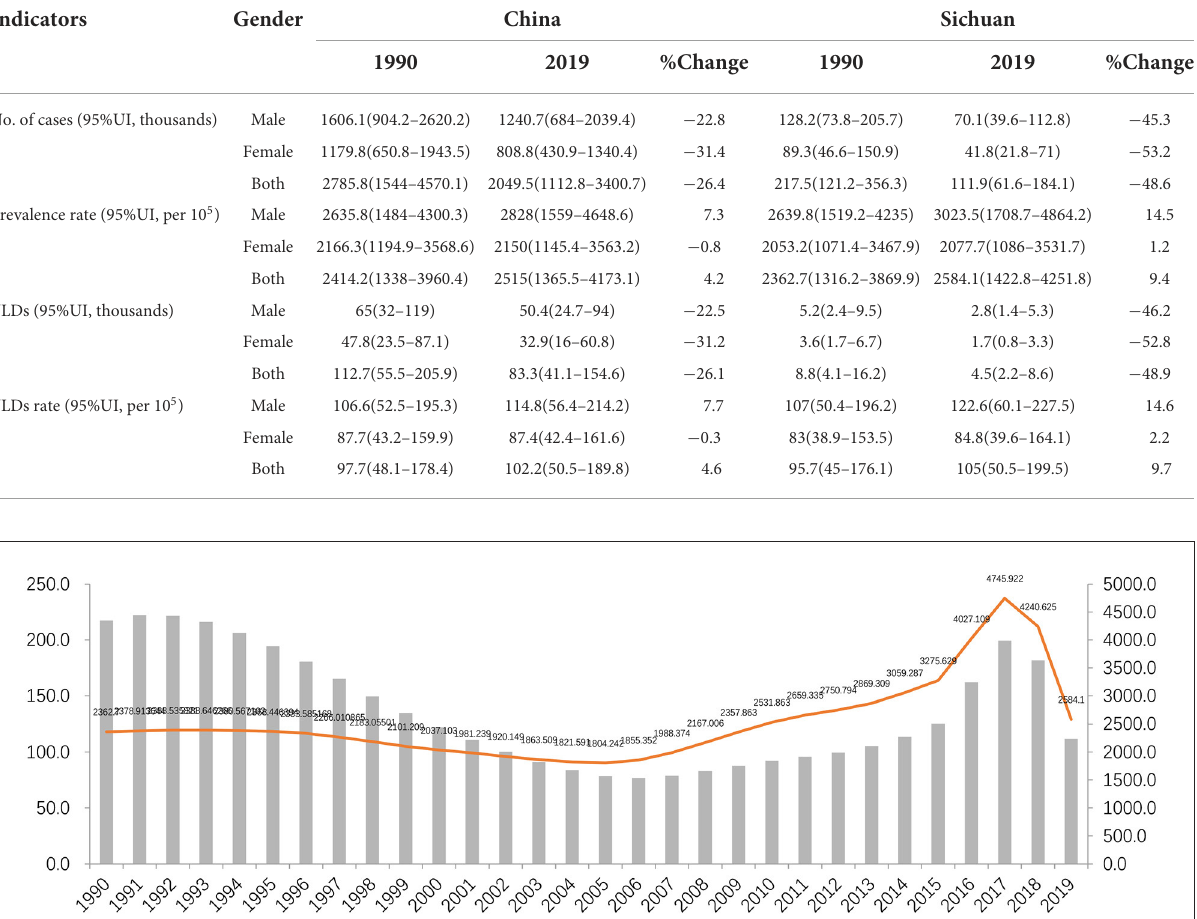
TABLE 1 Asthma prevalence and YLDs under 5 years old, 1990 to 2019 with percentage change.